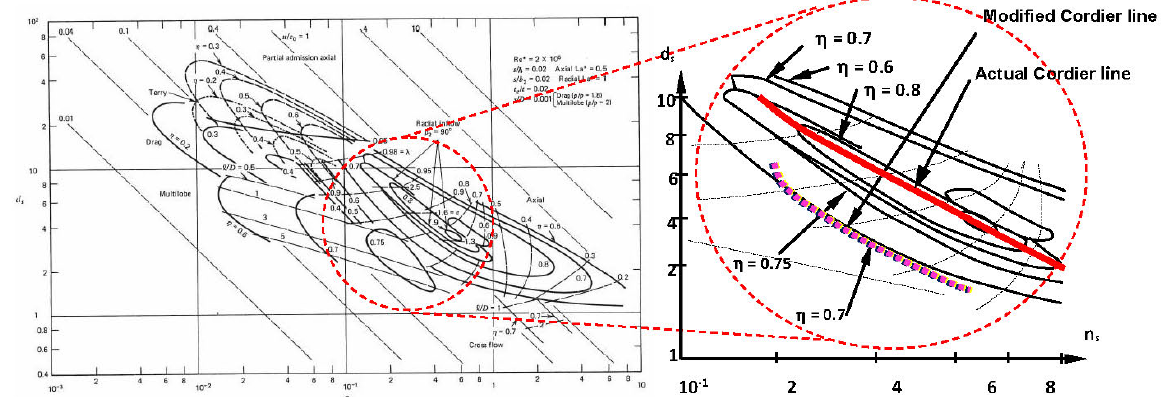
Figure 10. Radial turbines: the low-Re Cordier curve on the standard Balje turbine map. Comparison between the actual Cordier line and the Modified Cordier